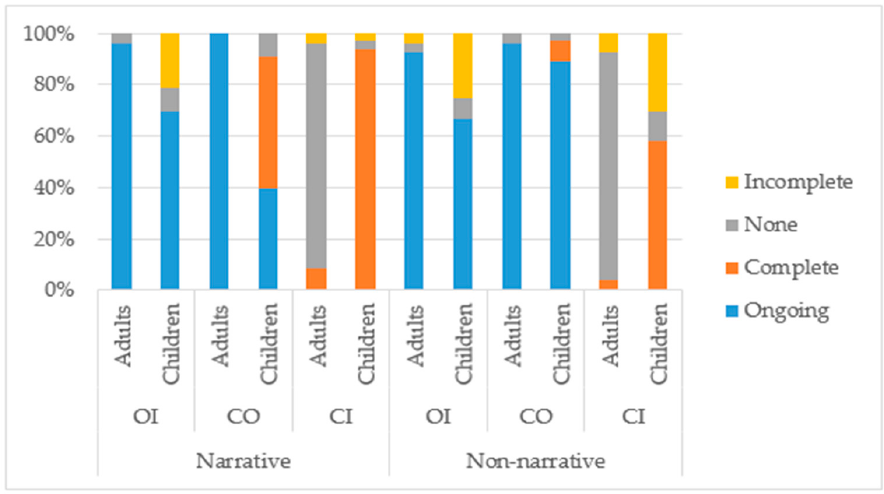
Figure 5. Picture choice for IMP for the three conditions (C–O, C–I, O–I) in the narrative and non-narrative settings.